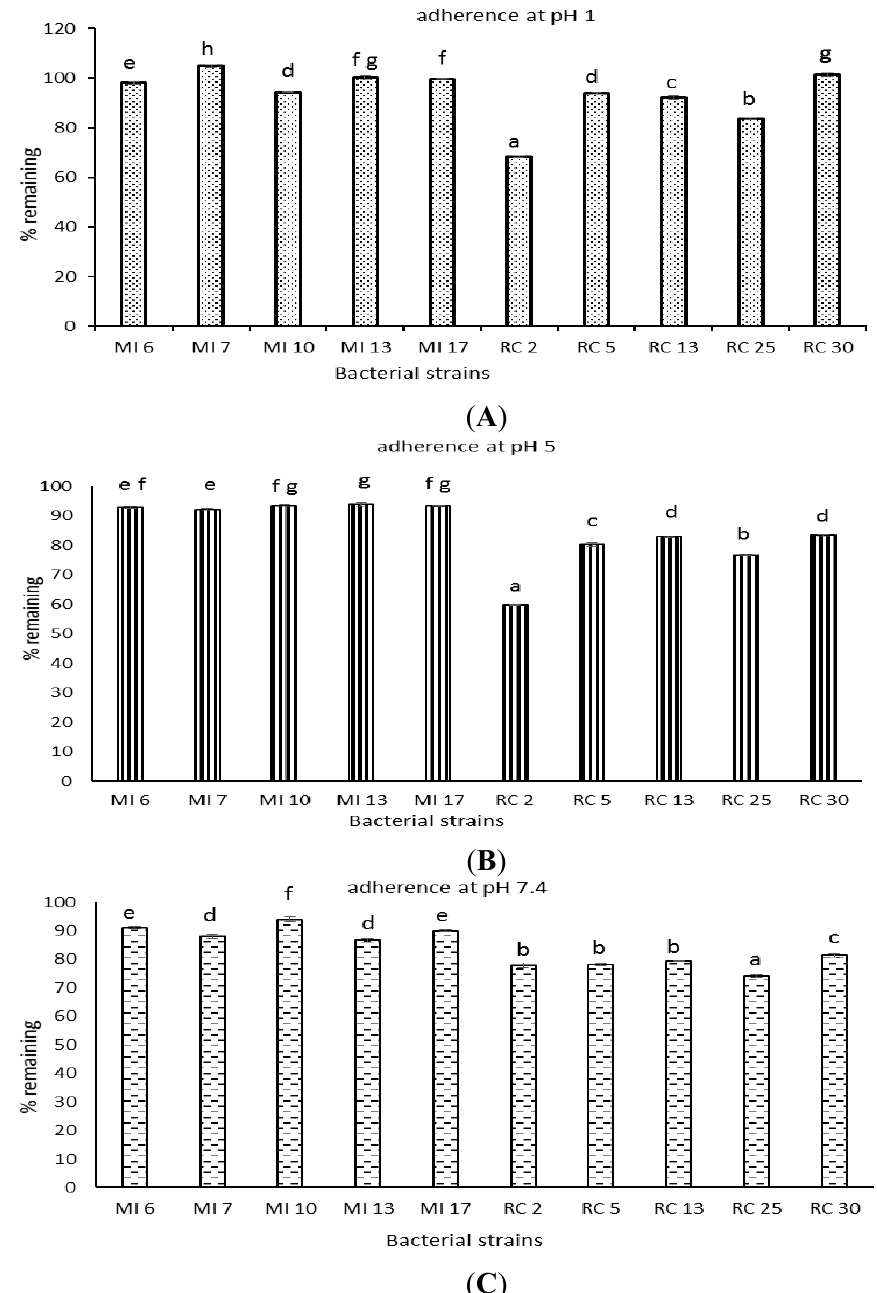
Figure 2. Percent initial OD at 600 nm following lactobacilli strains adherence at pH 1 ( A ); pH 5 ( B ); and pH 7.4 ( C ) to dichloromethane. Standard error of the mean bars ( n = 3) and columns with different letters for a given pH differ significantly ( p <